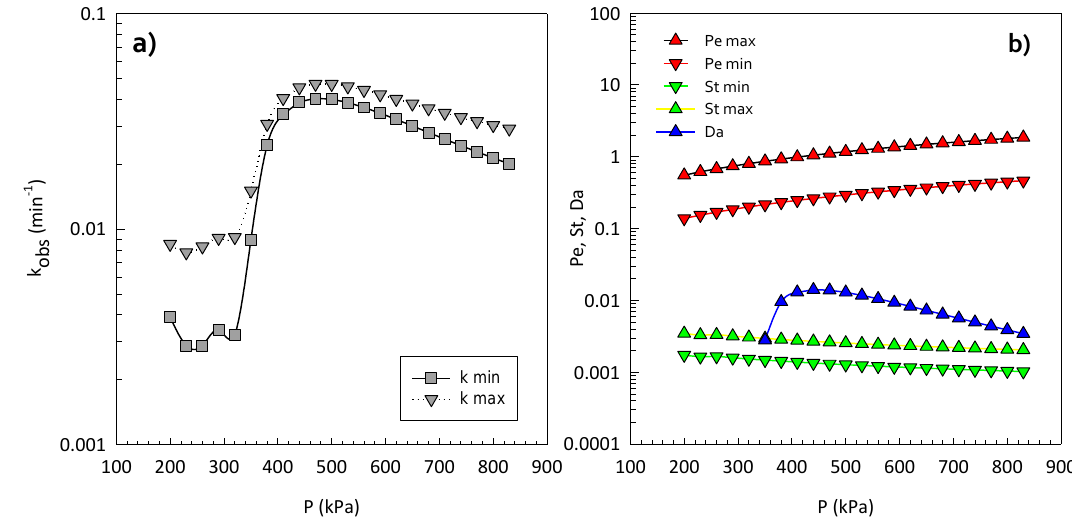
Figure 8. ( a ) Numerical results of the k obs into the CSTR vs. inlet pressure. ( b ) dimensionless number related to the modeling results. Values of other independent variables reported in Table 2.